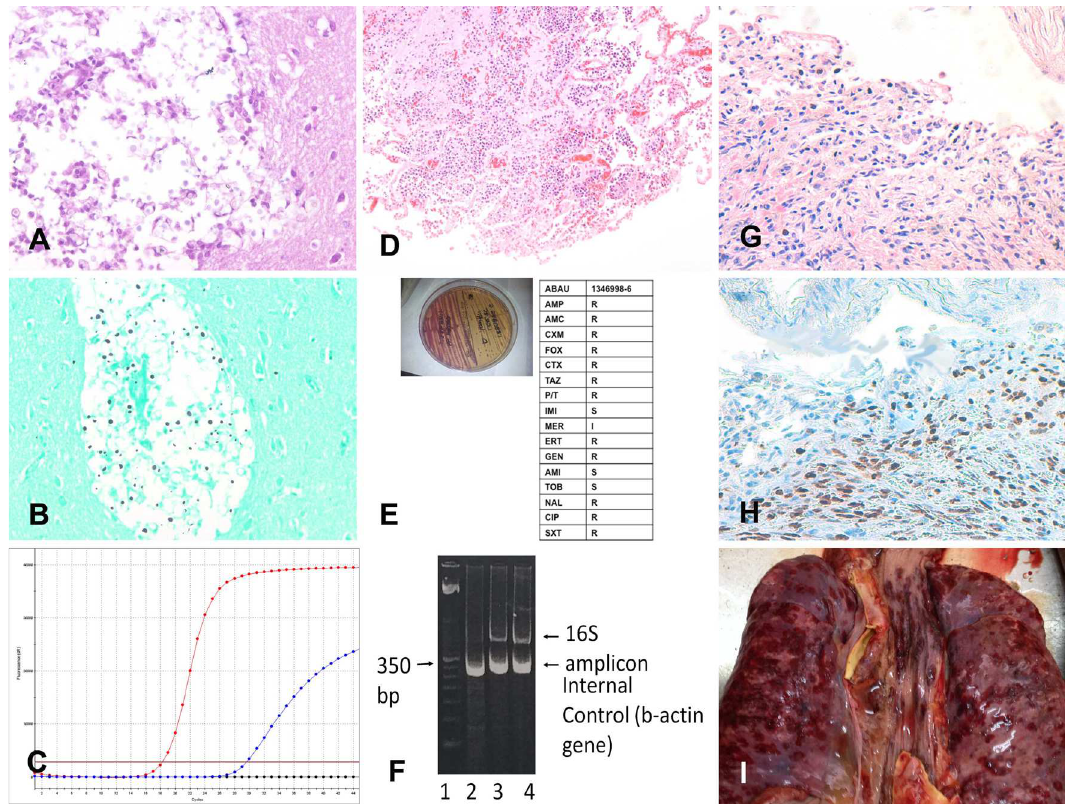
Fig 2. Three representative cases of cause of death identification by minimally invasive autopsy. (A–C) Cryptococcal encephalitis: (A) Cryptococcus spp. infecting the central nervous system (hematoxylin and eosin, 200 × ); (B) Cryptococcus spp. (methenamine silver stain, 200 × ); (C) real-time PCR positive for Cryptococcus spp. in the cerebrospinal fluid. (D–F) Acinetobacter baumannii pneumonia: (D) A . baumannii pneumonia infecting the lung (hematoxylin and eosin, 100 × ); (E) A . baumannii isolated (left side of the plate) and subjected to antibioticsusceptibility testing; (F) A . baumannii 16S RNA PCR amplification from tissue samples. (G–I) Disseminated Kaposi sarcoma: (G) Kaposi sarcoma involvingthe lung (hematoxylin and eosin, 100 × ); (H) Kaposi sarcoma involvingthe lung positive for human herpesvirus 8 (herpesvirus8 antibody, 100 × ); (I) disseminated Kaposi sarcoma lesions in the lung (red areas on the pleural surface of the two lungs and the trachea; macroscopicimage from the complete